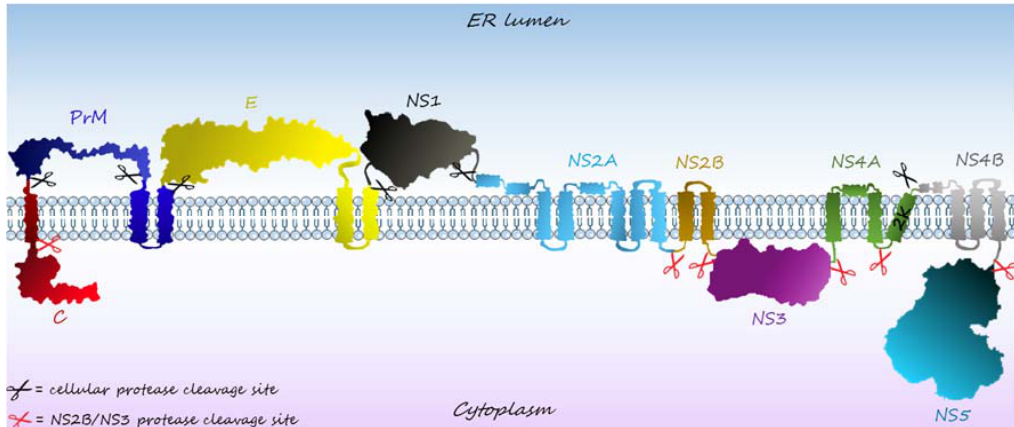
Figure 1. Schematic representation of the flaviviruses’ polyprotein. Viral RNA encodes a polyprotein that is co ‐ and post ‐ translationally processed by host proteases (black scissors) or by the viral protease NS2B/NS3 (red scissors) to generate the structural (C, PrM, and E) and non ‐ structural proteins (NS1, NS2A, NS2B, NS3, NS4A, NS4B, and NS5), represented in different colors.